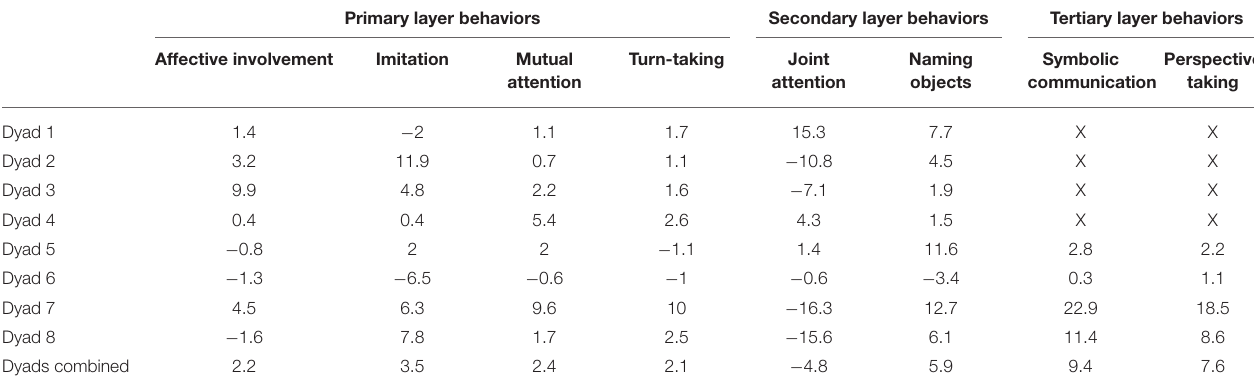
TABLE 12 | Difference between the percentage of presence of the behaviors during baseline and follow-up. Primary layer behaviors Secondary layer behaviors Tertiary layer behaviors Affective involvement Imitation Mutual Turn-taking Joint Naming Symbolic Perspective attention attention objects communication